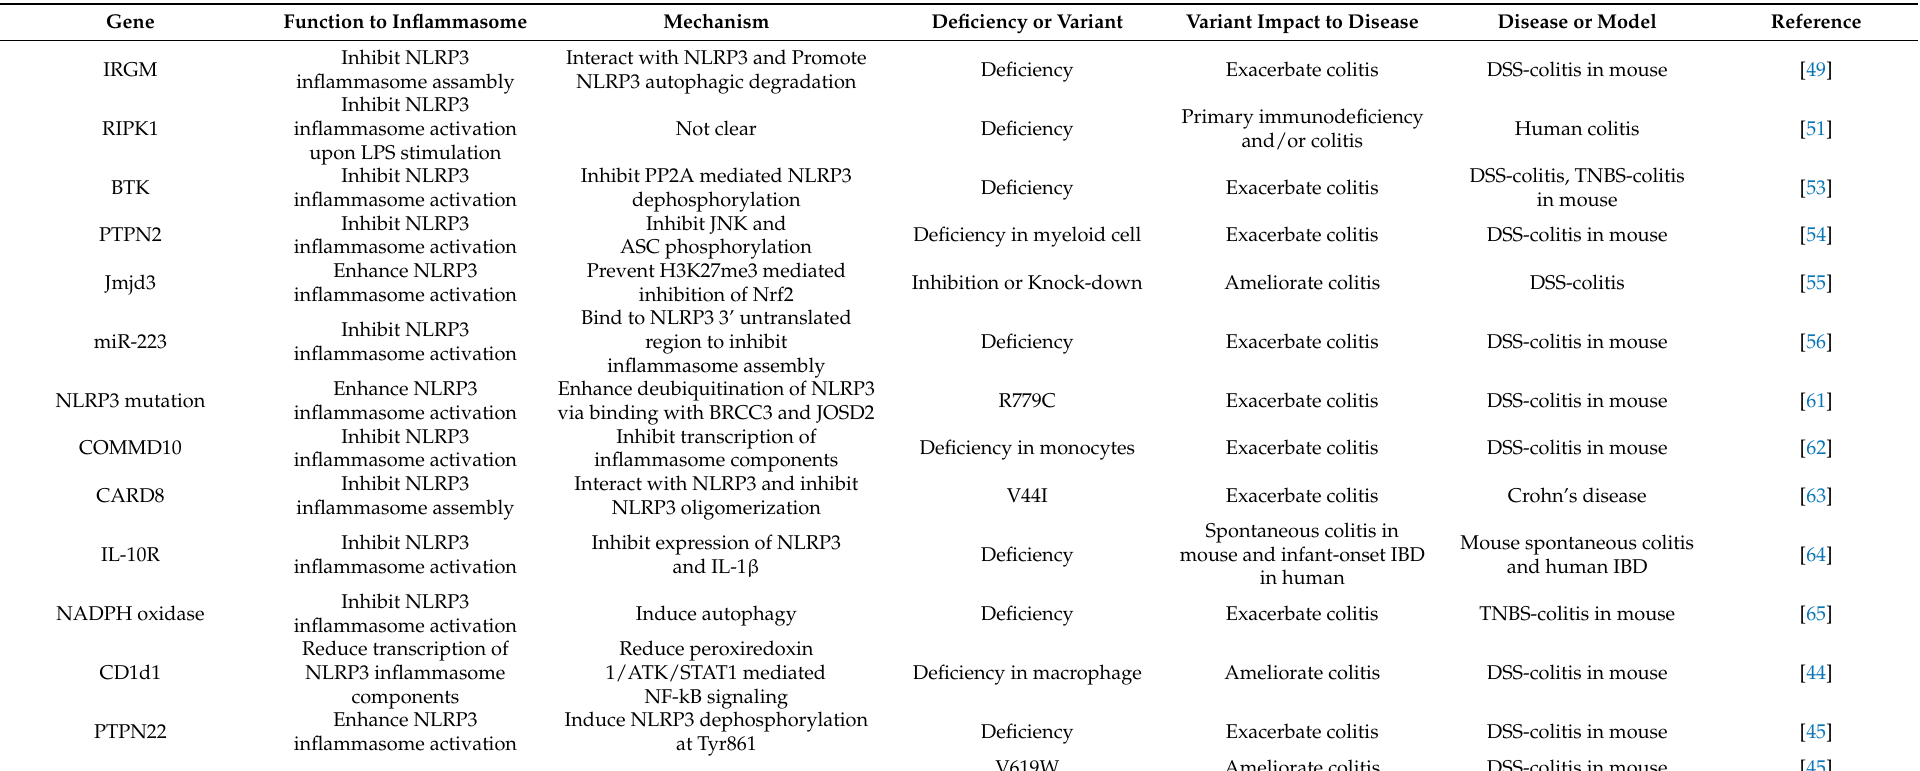
Table 1. Genetic factors affect IBD by regulating the activation of